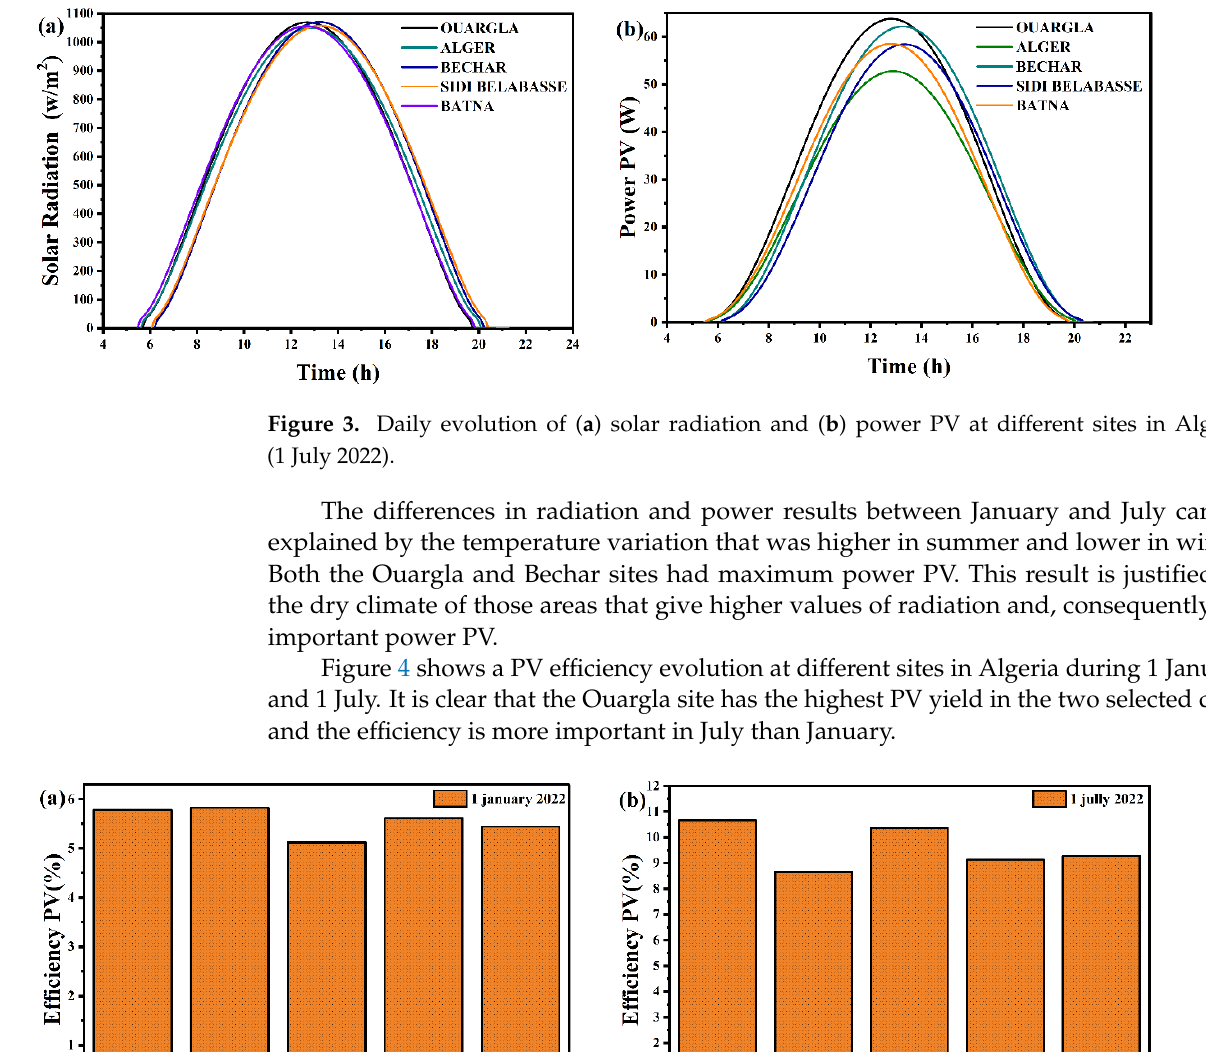
Figure 2. Daily evolution of ( a ) solar radiation and ( b ) power PV at different sites in Algeria (1 Jan- uary 2022).